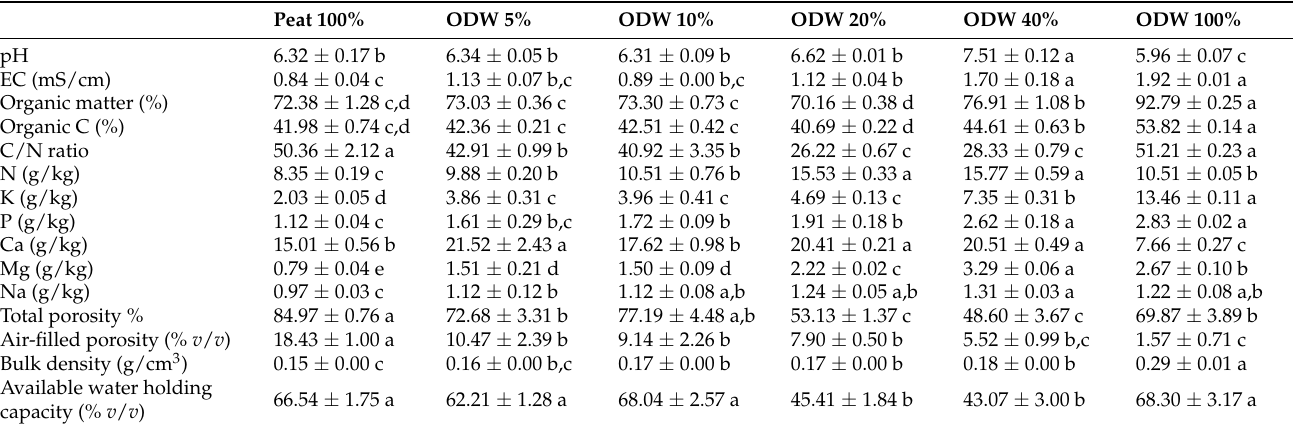
Table 1. Growing media (peat, Origanum dubium waste—ODW) physicochemical properties before plant transplanting.